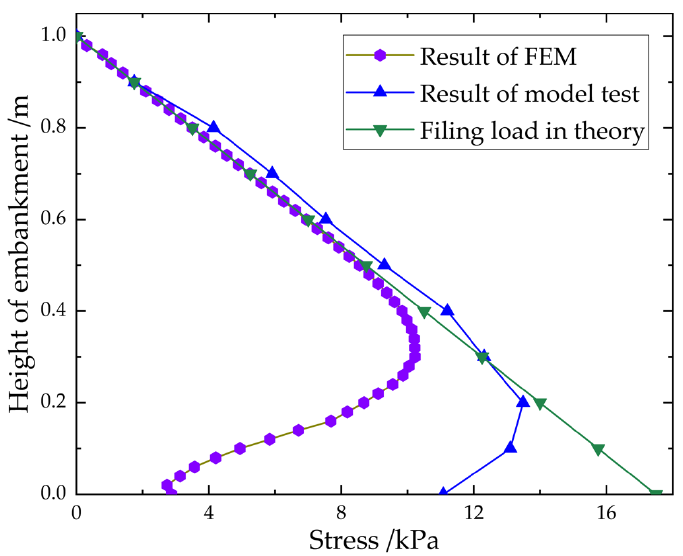
Figure 11. Verification of the finite element method. Figure 13. Vertical displacement distribution inside of embankment, ( a ) h = 50 mm; ( b ) h = 150 mm; ( c ) h = 250